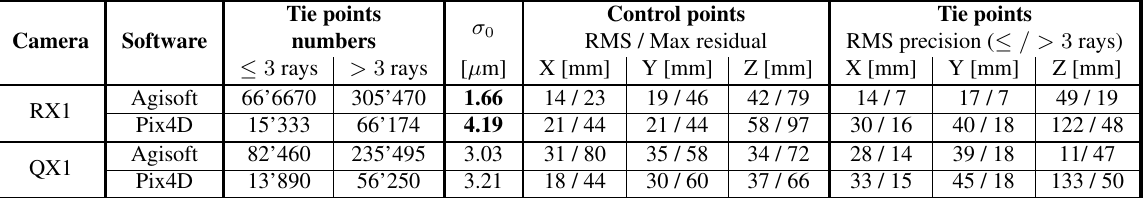
Table 3: Statistics from BINGO computation for both camera / softwares. RMS precision value of Tie points are computed from the cofactor matrix Qxx and σ 0 .